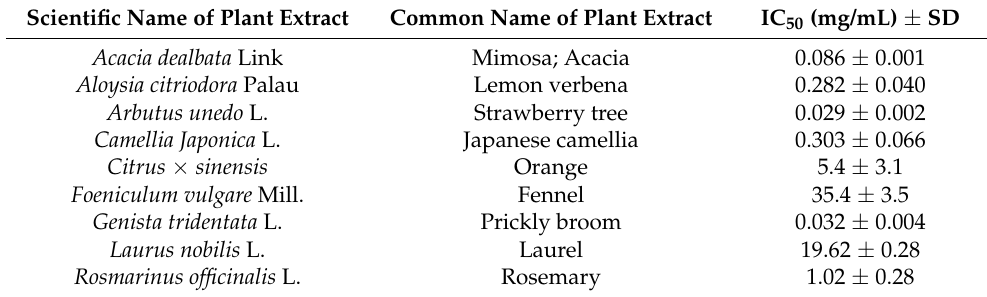
Table 1. Different plant extracts tested for myeloperoxidase inhibition and their IC 50 .